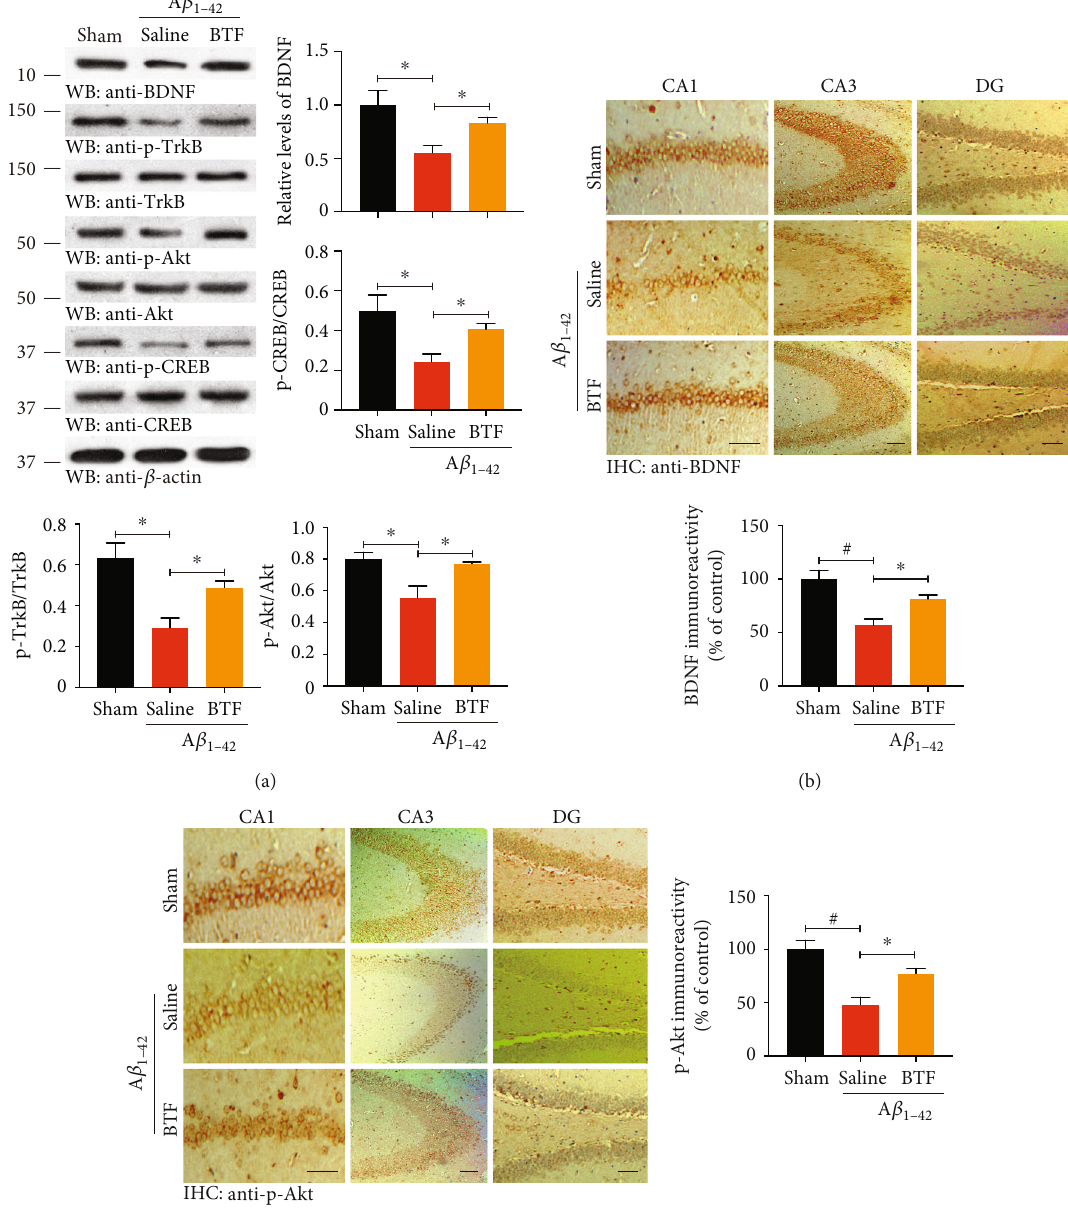
Figure 4: BTF promotes BDNF expression and activates downstream signaling pathways in the rat brain. (a) BDNF-TrkB signaling pathways were analyzed by immunoblotting with the indicated antibodies. The expression of BDNF induced by BTF triggered the phosphorylation of TrkB, Akt, and CREB. (b, c) IHC staining for BDNF (b) and p-Akt (c) in di ff erent hippocampal regions. BTF treatment signi fi cantly escalated fi bril-infused rats, which were consistent with Western blot results. Quanti fi cation of BDNF intensity their expression in A β 1 – 42 ( F ð 2, 12 Þ = 12 : 21 , p = 0 : 0013 ) and p-Akt intensity ( F ð 2, 12 Þ = 14 : 27 , p = 0 : 0007 ) are shown. Data are represented as of 12-18 sections prepared from three rats in each group. Scale bar, 150 μ m. ∗ p < 0 : 05 , # p < 0 : 001 by one-way ANOVA with Tukey ’ s multicomparison test. Western blot data are representative of three independent